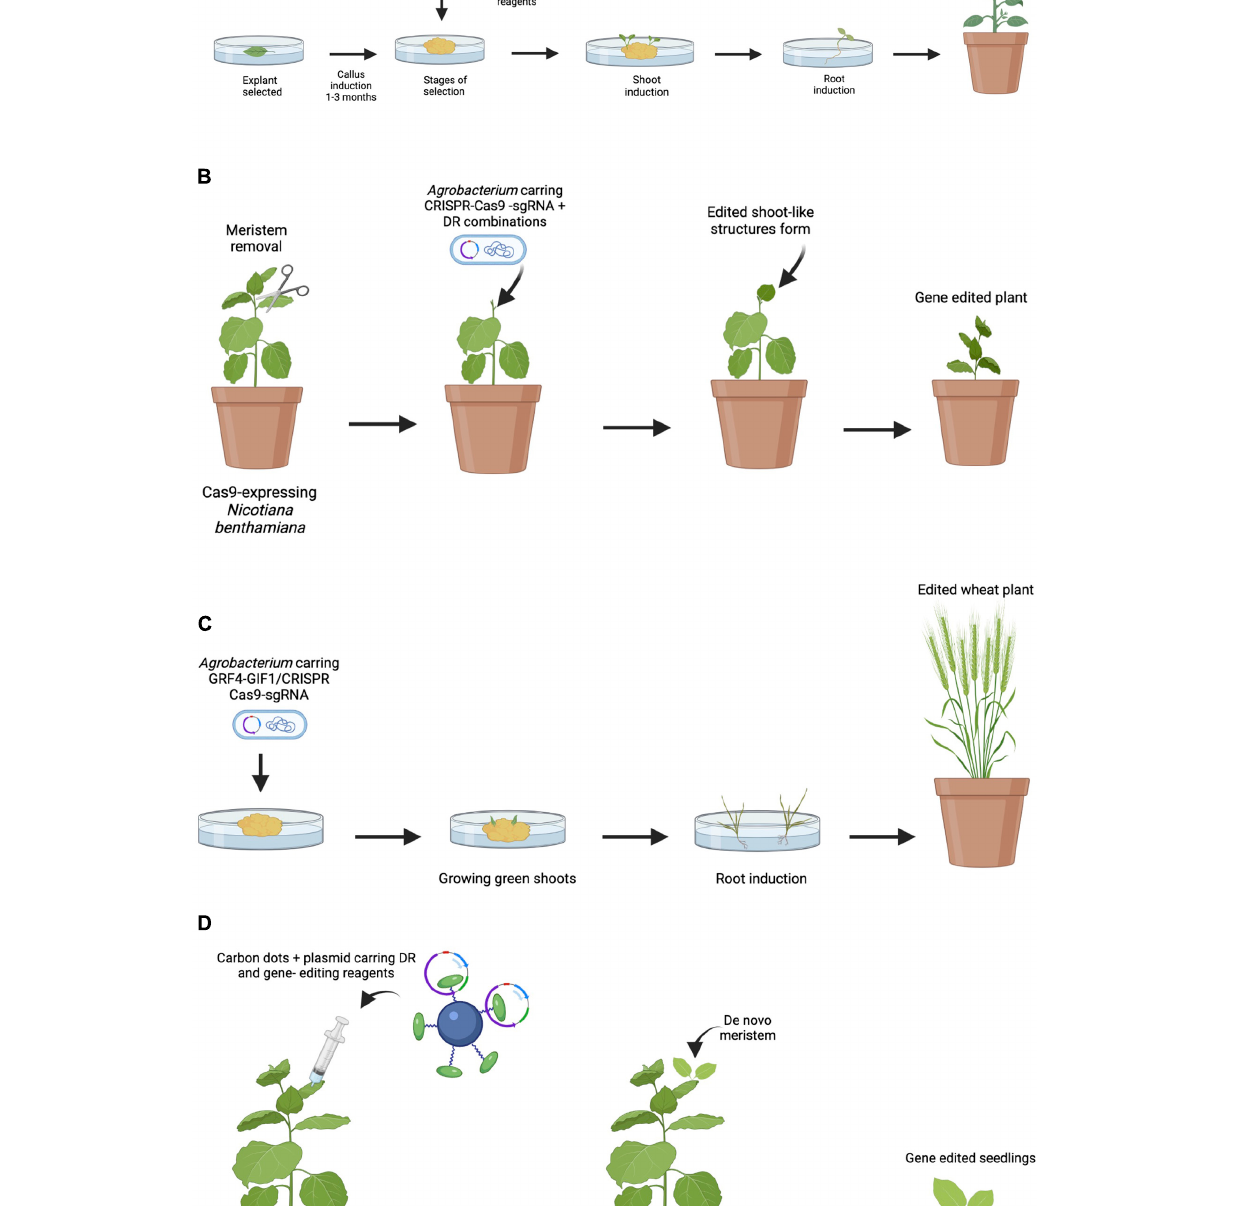
Frontiers in Plant Science |